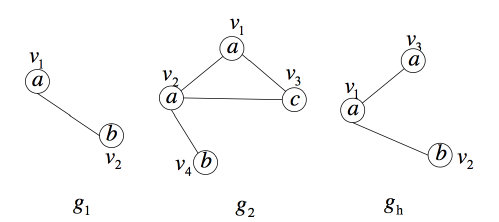
Figure 7. An example to show isomorphism between the hypergraph and subgraph.